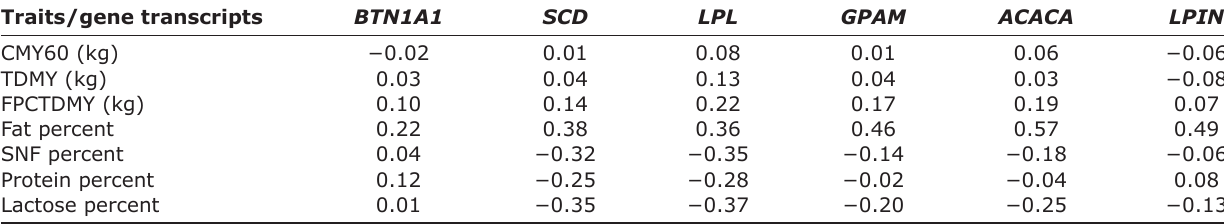
Table-7: Correlation coefficients among milk yield, composition and relative expression of major milk lipogenic genes in Surti buffaloes at day 60 pp. Traits/gene transcripts BTN1A1